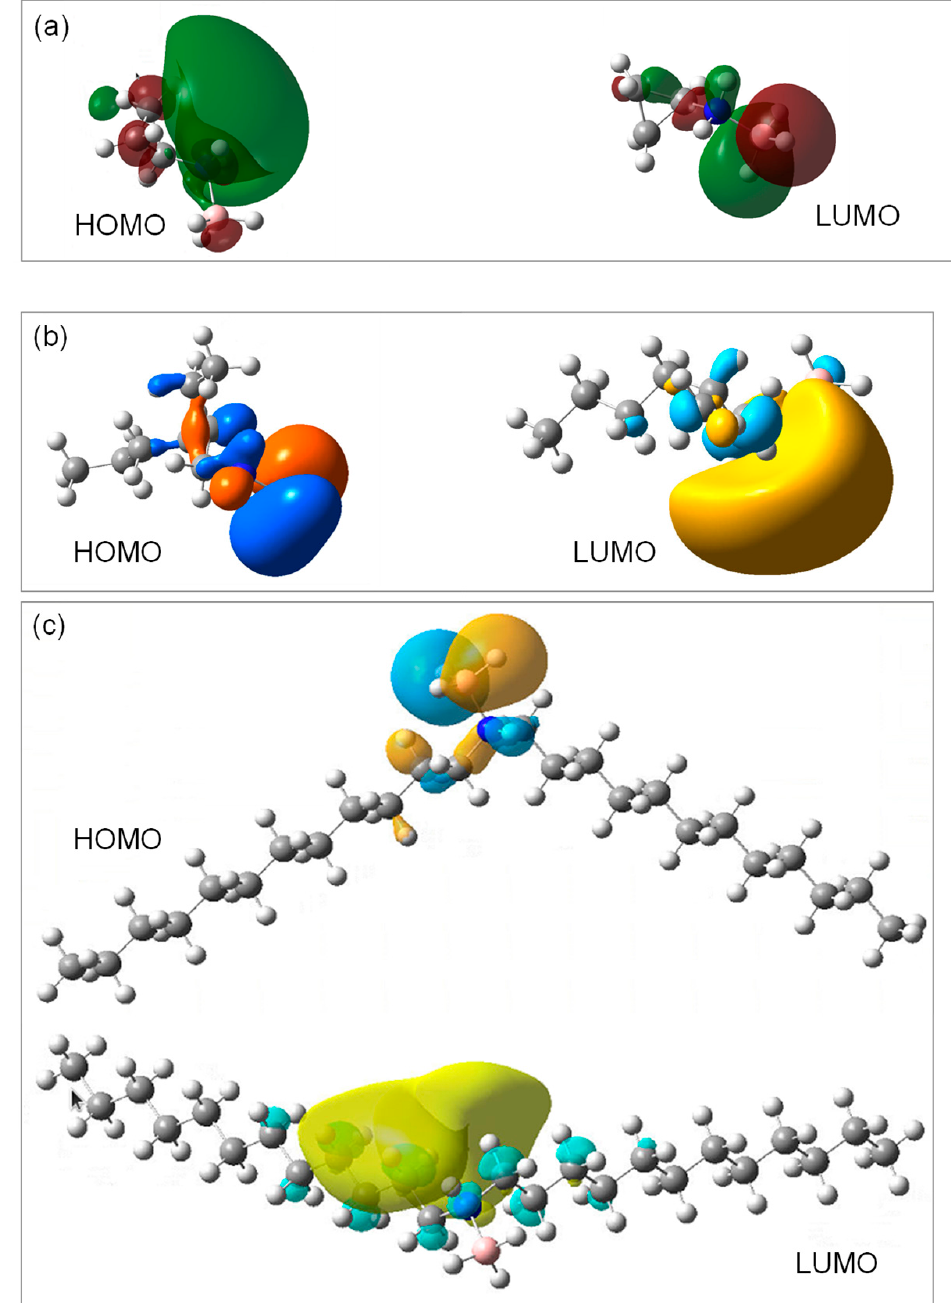
Figure 8. HOMO and LUMO of the ( a ) C3AB, ( b ) C2C6AB and ( c ) (C12)2AB molecules, as predicted by DFT calculations.